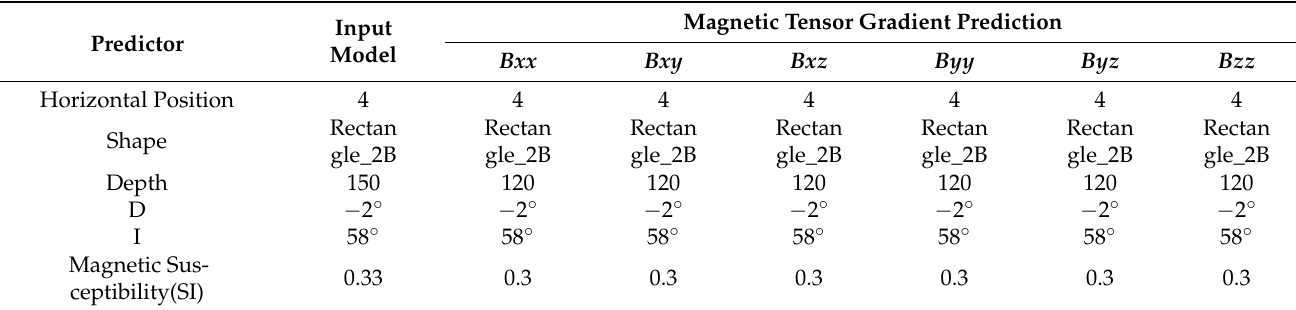
Table 5. Model Rectangle_2B parameter settings and prediction results of each independent